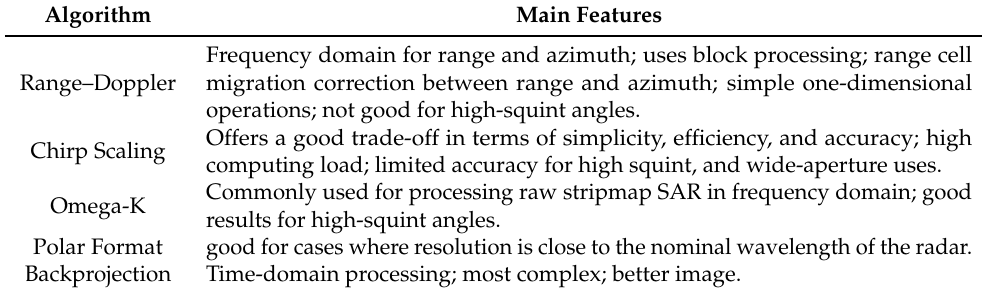
Table 3. Comparison between the Range–Doppler, chirp scaling, omega-K, polar format, and backprojection algorithms.